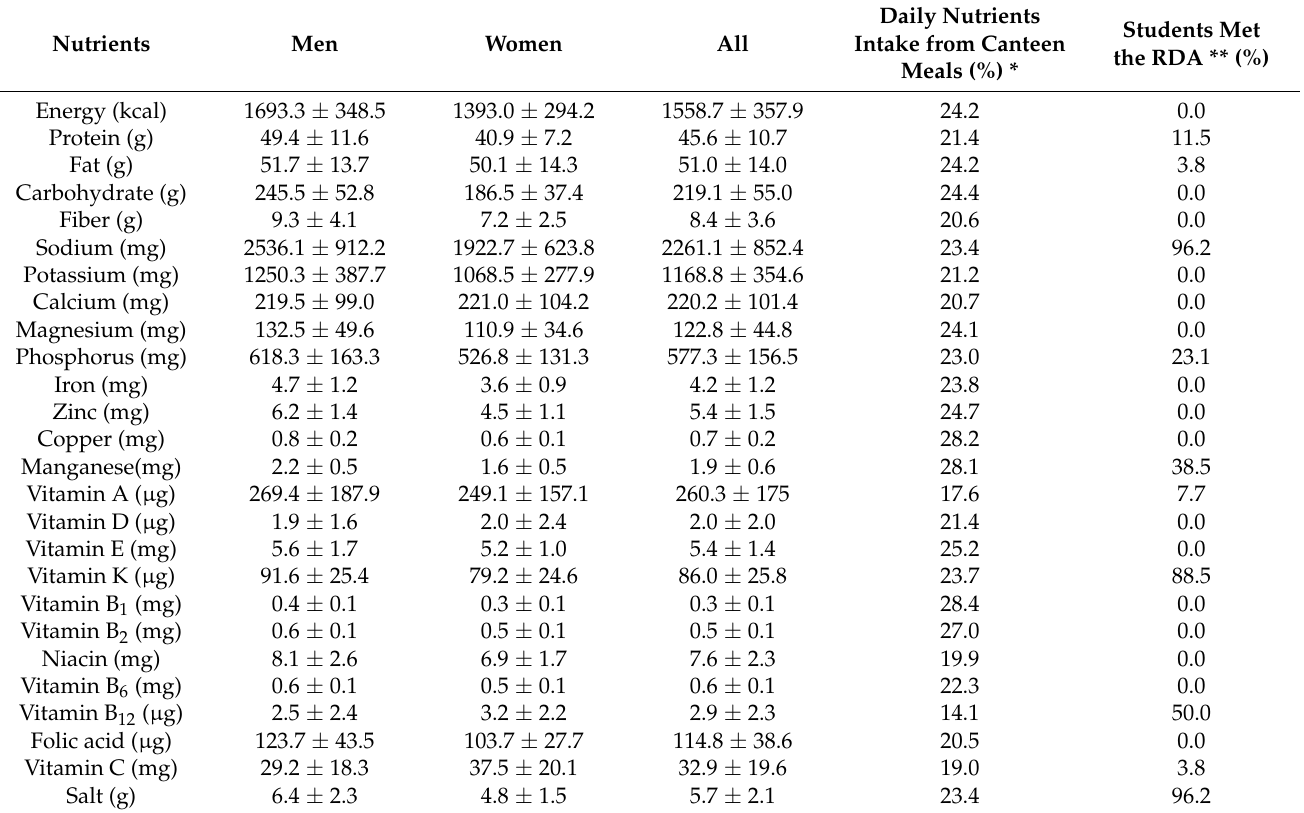
Table 4. The mean daily nutrient intake and the percentage of students who met the RDA.